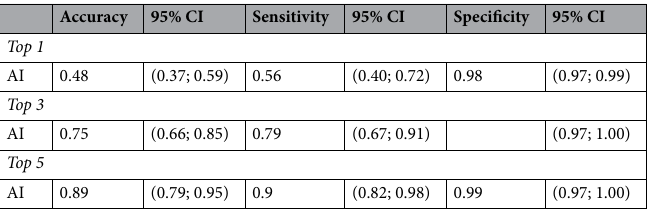
Table 4. Accuracy, sensitivity and specificity of the ML model with diagnoses for which it has been trained (n = 82). AI Artificial intelligence, TD Teledermatology, PC Primary care.